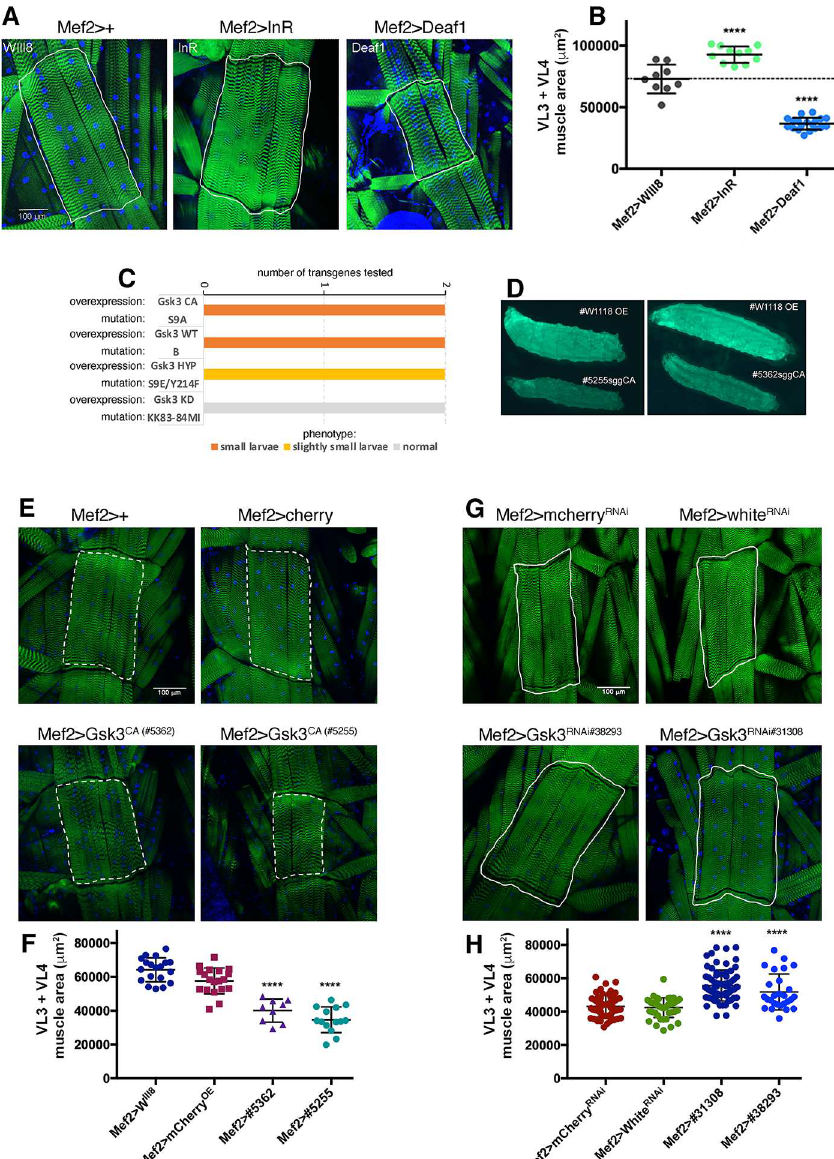
Fig 3. Muscle-restricted activity of Deaf1 and Gsk3 impedes developmental muscle growth. (A) Transgenic overexpression of the transcription factor Deaf1 , driven specifically in skeletal muscle with Mef2-Gal4 , leads to a reduction in the area of larval muscles, each consisting of a single myofiber, compared to controls with no transgene expression ( Mef2 > + ). (B) The area of ventral longitudinal VL3 and VL4 muscles is lower upon Deaf1 overexpression, whereas it increases upon insulin receptor ( InR ) overexpression. N = 9–19 and mean ± SD is shown; ���� P < 0.001. (C) Gsk3 transgenic overexpression driven in skeletal muscle with Mef2-Gal4 leads to small size of 3rd instar larvae in a manner proportional to Gsk3 kinase activity: Gsk3 CA (constitutive active) and WT (wild-type) induce atrophy, hypomorphic (HYP) mutants with only limited kinase activity have little impact, whereas KD (kinase-dead) Gsk3 mutants do not affect developmental muscle growth. (D) Gsk3 activity in muscle reduces body size, as indicated by larvae where body wall skeletal muscle are shown by expression of Mhc-GFP. (E) Compared to controls (no transgene and mcherry overexpression), overexpression of 2 different Gsk3 CA transgenes with Mef2-Gal4 leads to a decrease (atrophy) in the size of myofibers, as indicated by the quantitation of the cumulative area of VL3 and VL4 muscles from multiple larvae (F); N = 9–19 and mean ± SD is shown; ���� P < 0.0001. (G) Conversely, Gsk3 RNAi in skeletal muscle induces myofiber hypertrophy, as indicated by the the cumulative area of VL3 and VL4 muscles (H); N = 27–71 and mean ± SD is shown; ���� P <